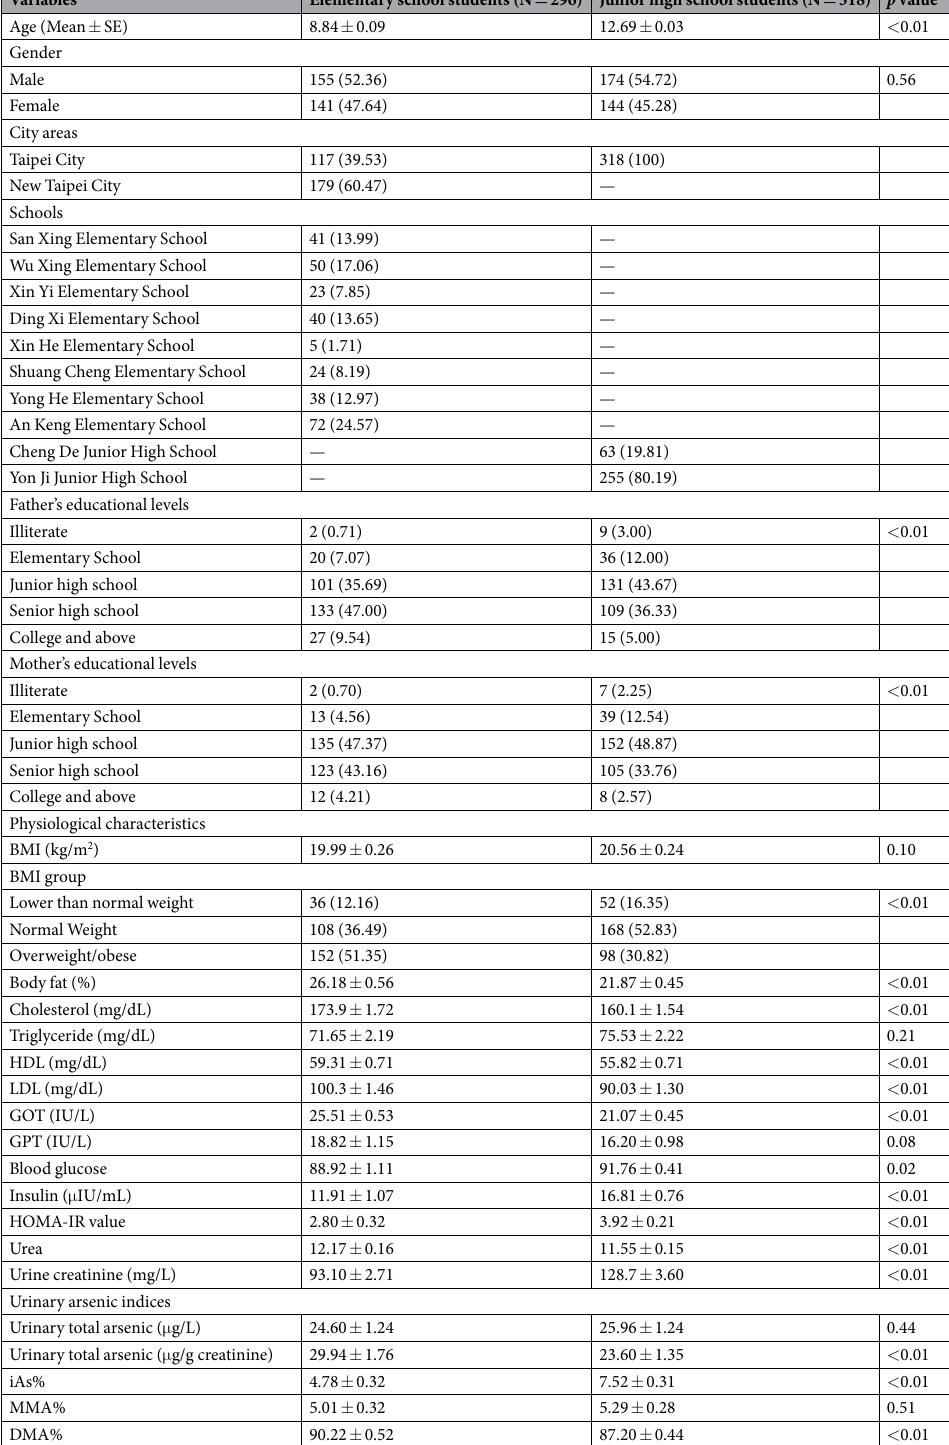
Table 1. Physiological characteristics and urinary arsenic profiles stratified by educational levels. Categorical and continuous variables are expressed as numbers (percentage) and mean ± Standard error, respectively. HDL, high-density lipoprotein; LDL, low-density lipoprotein; GOT, glutamic oxaloacetic transaminase; GPT, glutamic pyruvic transaminase. HOMA-IR, Homeostasis model assessment of insulin resistance; HOMA-IR = Fasting unavailable for three children; educational levels were unavailable for 31 children’ fathers and 18 children’